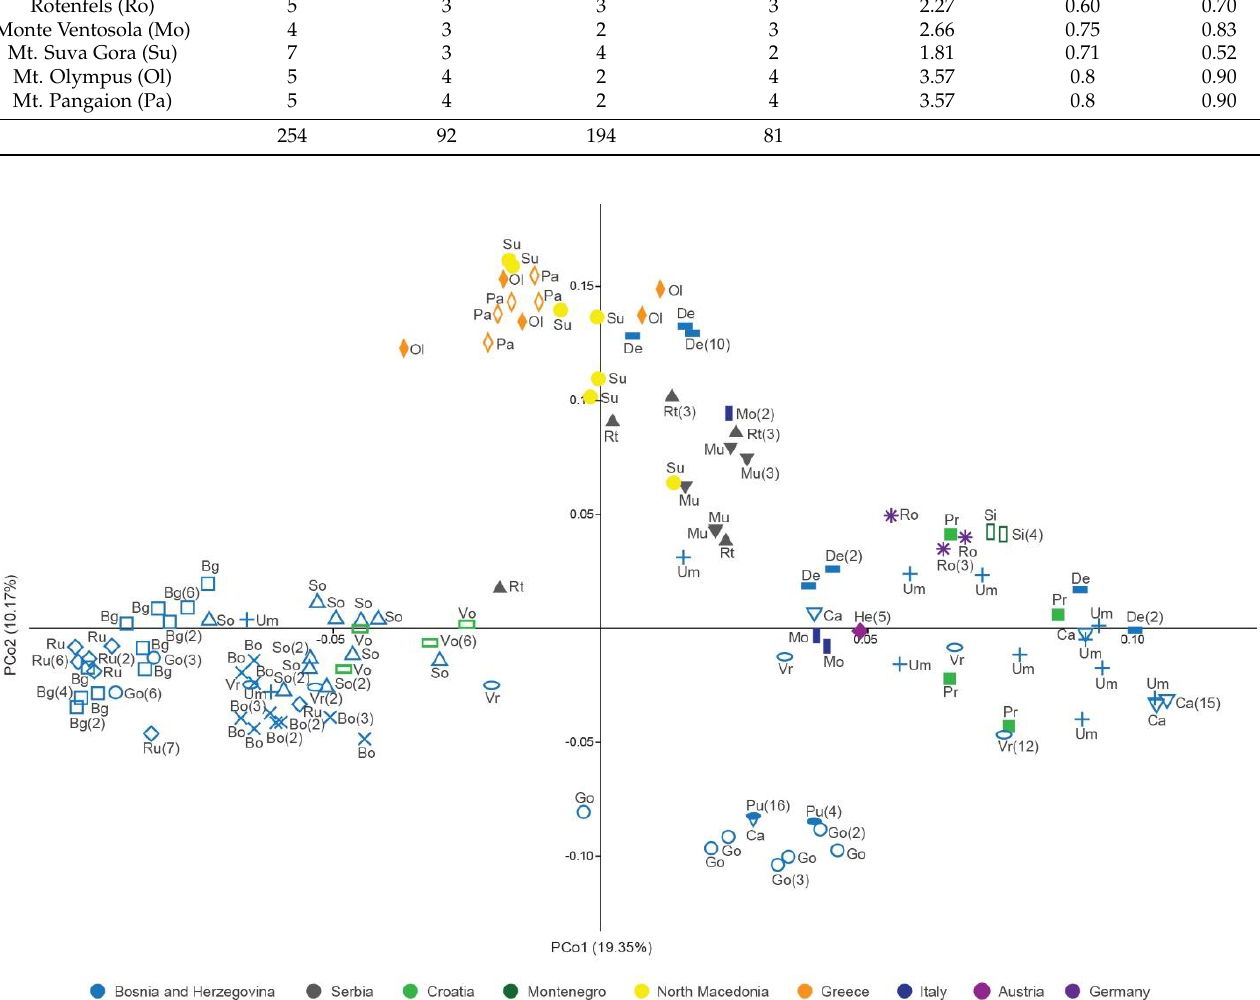
Figure 3. Principal coordinate analysis of the Jaccard distance matrix of multilocus genotypes of Cotoneaster integerrimus polyploids according to nuclear microsatellite data. Population abbreviations correspond to those in the Table 4. The numbers in the brackets denote the number of clones.